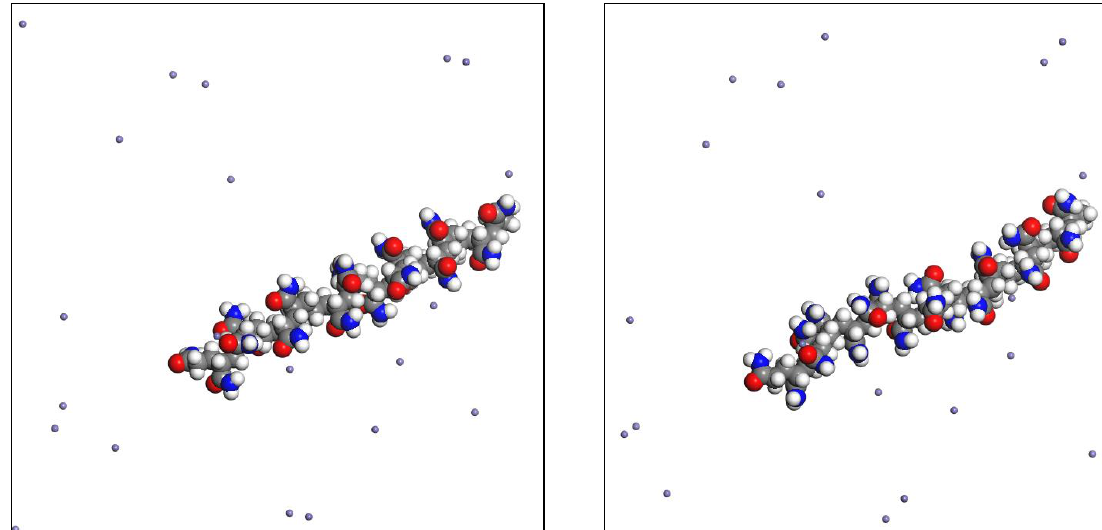
Figure 6—PAM polymer's 3D configuration alteration before NVT beginning (left) and after 20ps simulation (right). Purple dots around the 20-unit PAM molecule are Fe 2+ .